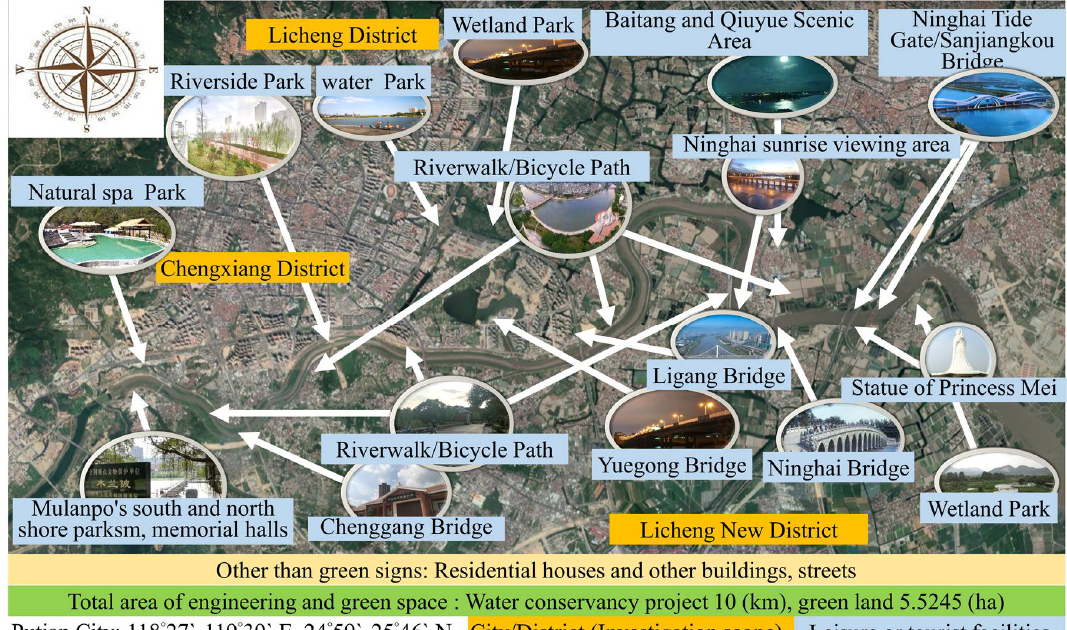
Figure 1. Distribution of the development and construction of the Mulan River improvement and greening project.